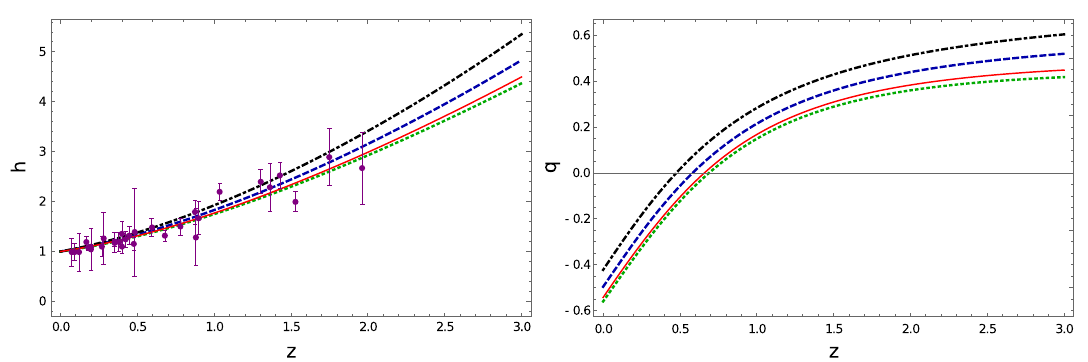
Fig. 1 The evolution of the Hubble parameter (left panel) and of the deceleration parameter (right panel) as a function of the redshift z in the linear case φ( z ) = 1 + δ z . The dashed, dotted and dot-dashed curves